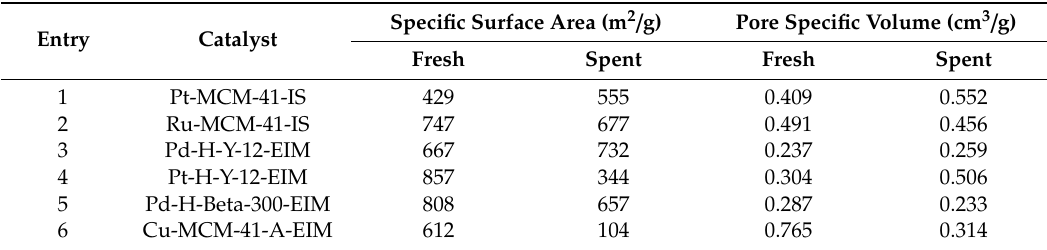
Table 2. Specific surface area and pore volume of Pt-MCM-41-IS, Ru-MCM-41-IS,